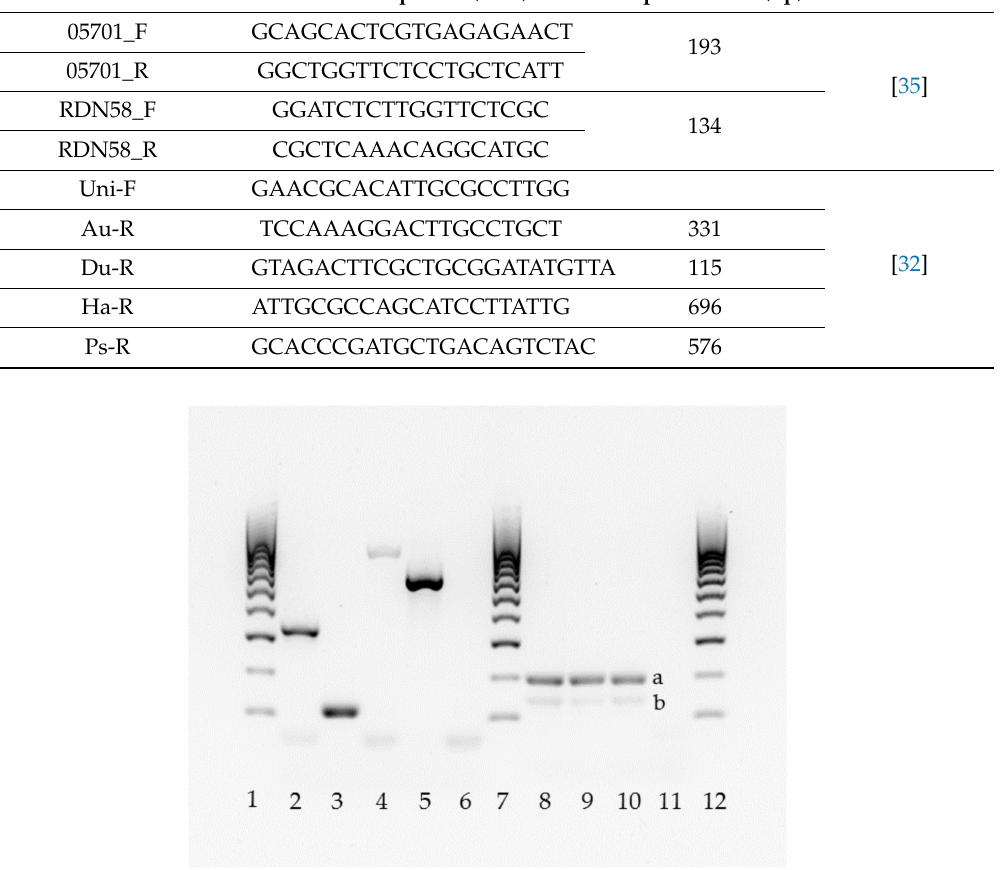
Figure 1. Molecular identification of the C. haemulonii complex by two PCR methods (lanes 2–6 [32]; lanes 8–11 [35]). Lanes 1, 7, and 12: 100 bp DNA ladder. Lane 2: C. auris ; 3: C. duobushaemulonii ;